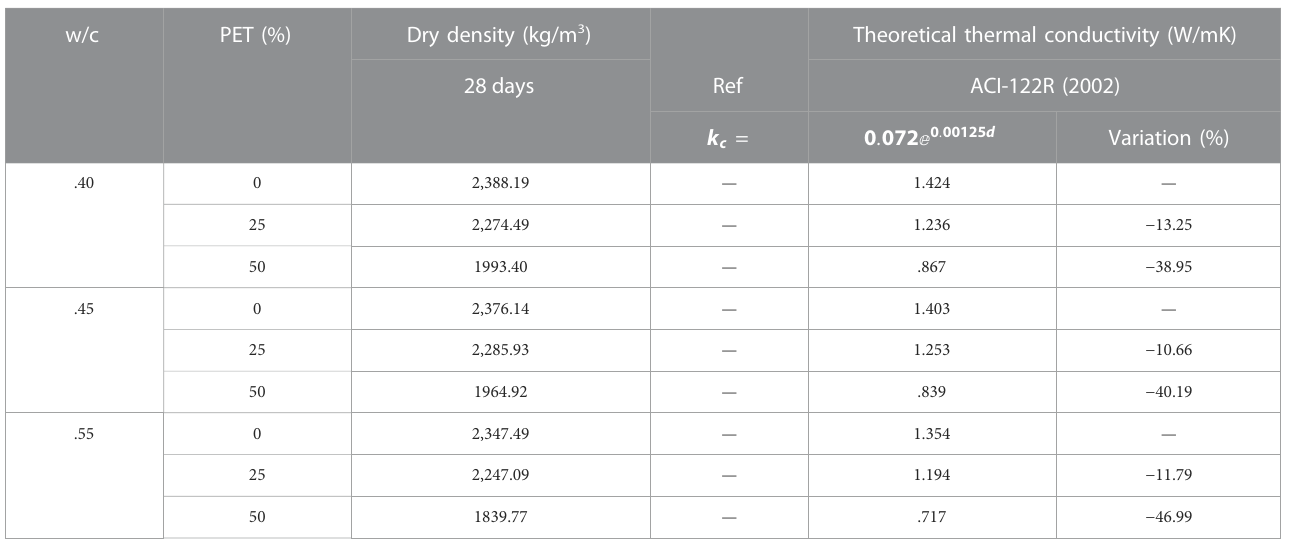
TABLE 8 Thermal conductivity test